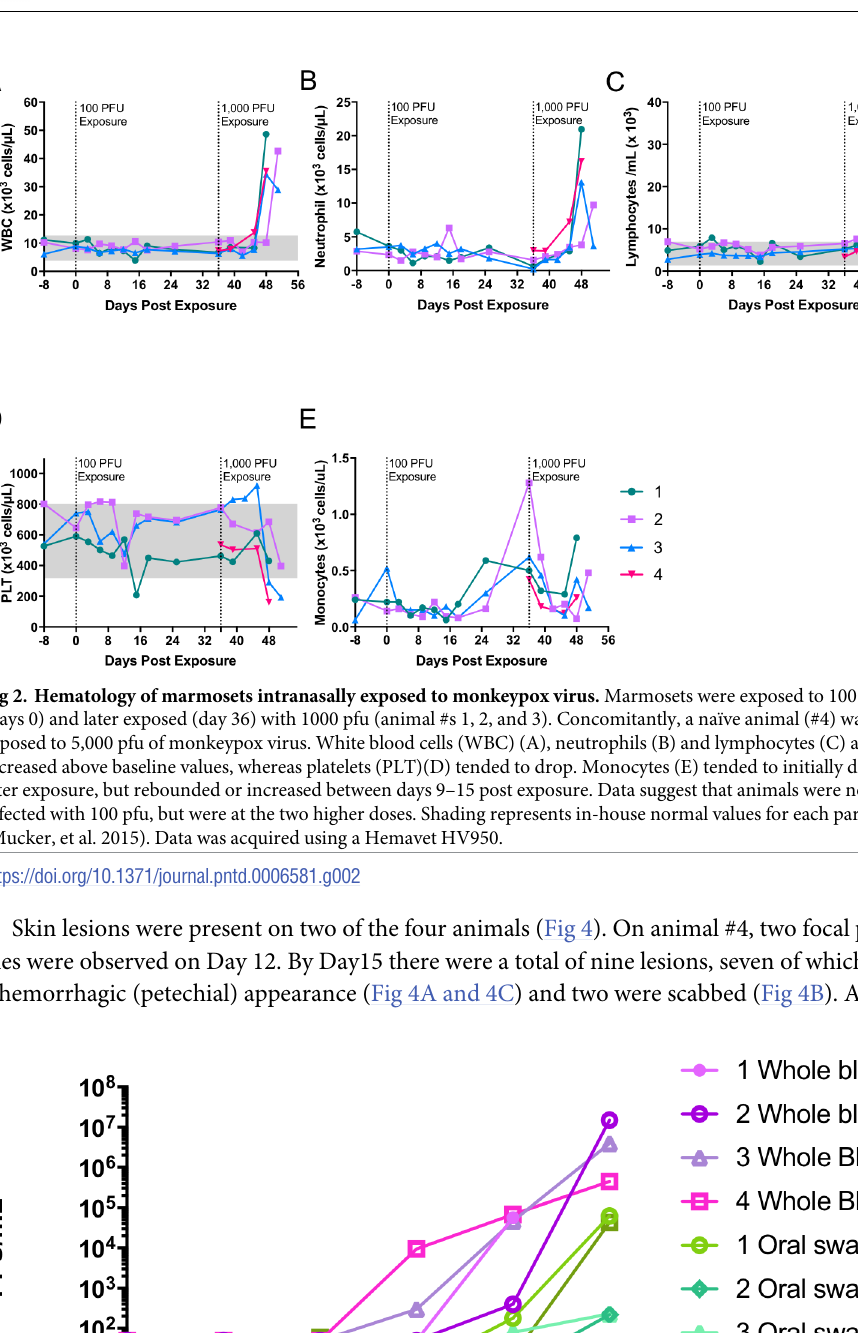
Fig 3. Viremia and viral shedding in marmosets exposed to intranasal monkeypox virus. Whole blood and oral swabs were processed and titrated onto BSC-1 cells. Two of four animals had detectable levels of virus in blood samples on the Day 9. Virus from oral swabs was detectable as early as day 6 (high dosed animal #4). Limits of detection for whole blood (dashed orange line) and for oral swabs (dashed blue line). All animals were positive to varying extents. Notice the onset of oral shedding relative to